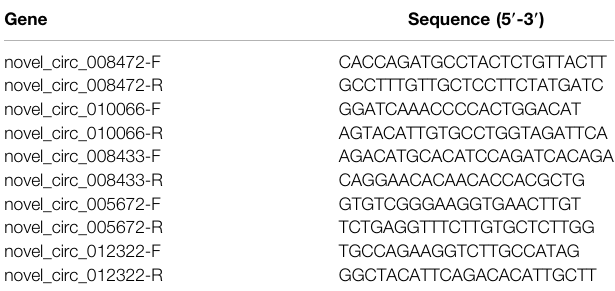
TABLE 1 | Primers sequences. TABLE 2 | Meat quality and carcass traits